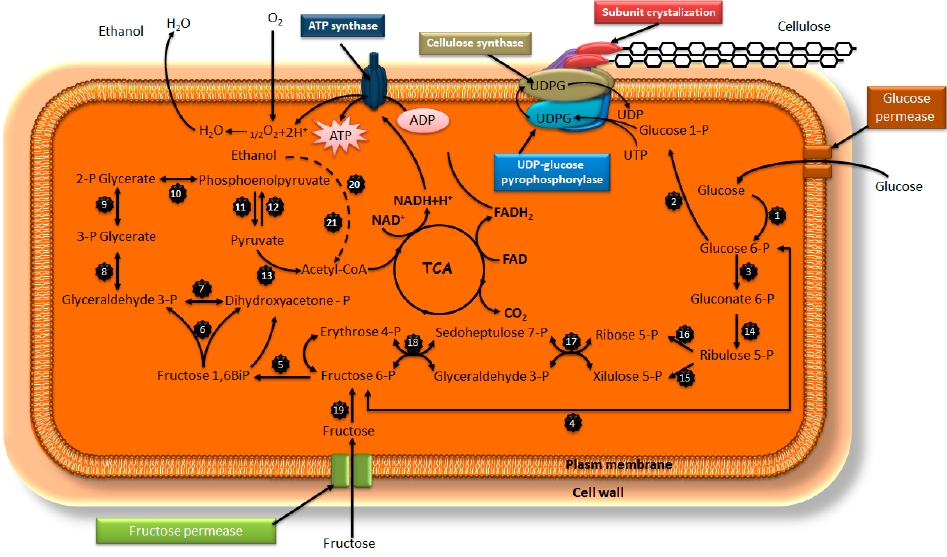
Figure 2. Hypothetical model of the pathway for the biosynthesis of cellulose by G. xylinus from exogenous sources: glucokinase-ATP (1); Phosphoglucomutase (2), glucose-6-phosphate dehydrogenase (3); Phosphoglucoisomerase (4); Fructokinase ATP (5), Aldolase (6); Triosephosphate isomerase (7); Glyceraldehyde 3-phosphate dehydrogenase (8); Phosphoglycerate mutase (9), enolase (10); Pyruvate kinase (11); Pyruvate biphosphate kinase (12), pyruvate dehydrogenase (13); 6-phosphogluconate dehydrogenase (14); Phosphorribulose epimeraase (15); Phosphorribulose isomerase (16); Transaketolase (17); Transaldolase (18); Fructokinase (19); Aldehyde dehydrogenase (20); Alcohol dehydrogenase (21) [28]. Copyright 1991 American Society for Microbiology